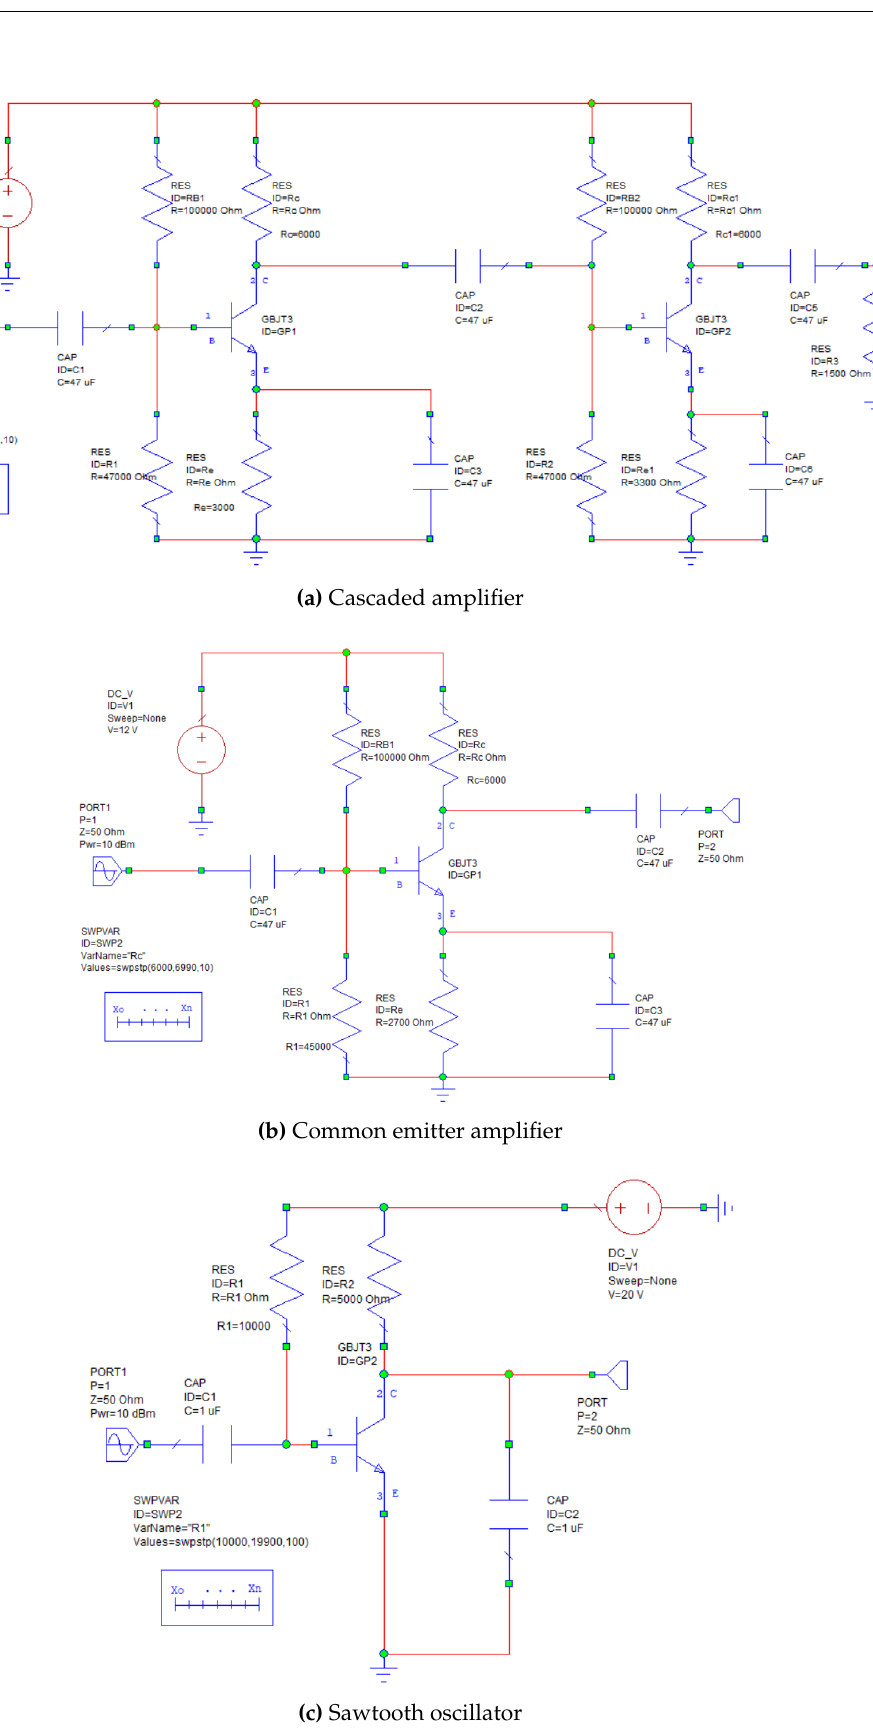
Figure 1. Schematics of the ECUTs.